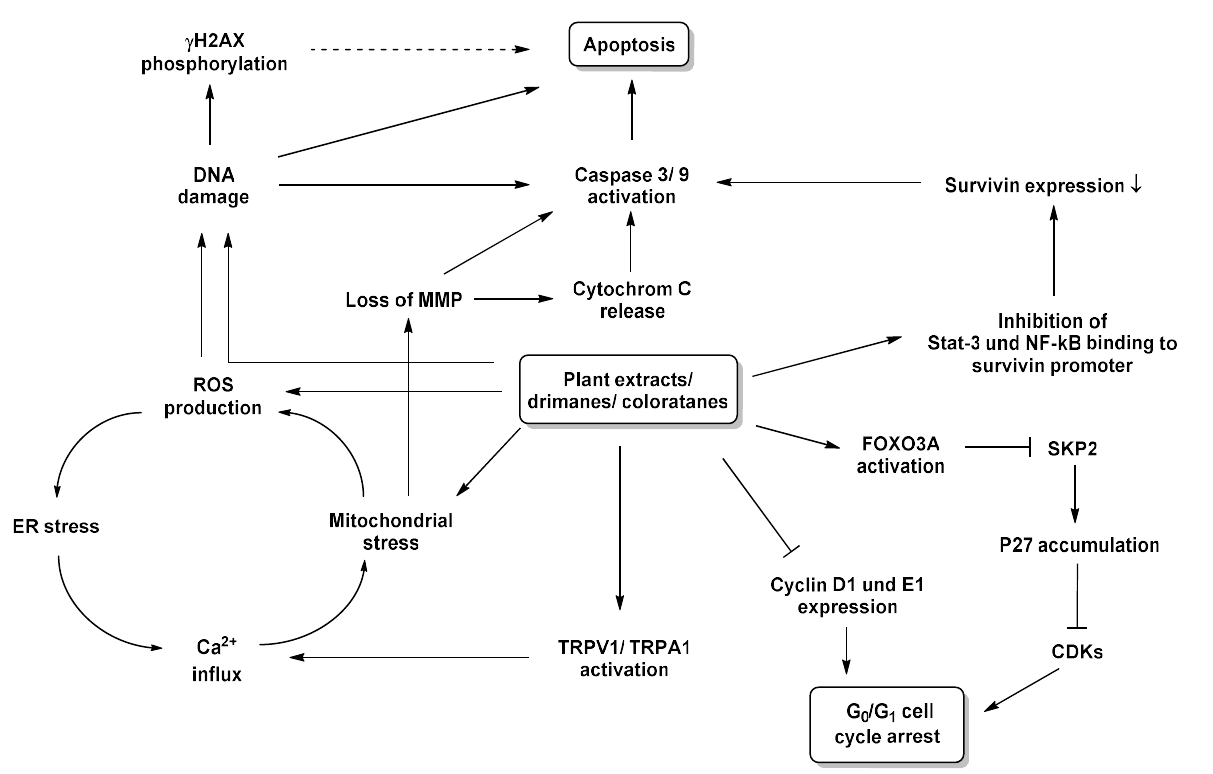
Figure 17. Schematic overview of potential modes-of-action of drimanes, coloratanes, and drimane- containing plant extracts.